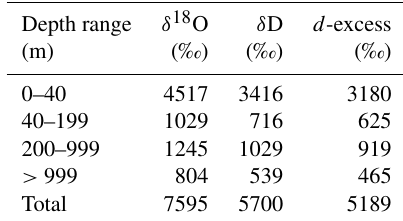
Table 3. Number of valid seawater isotopic data by depth range in Waterisotopes-CISE-LOCEAN (2021, version V2) (a total of 7595 valid data entries for δ 18 O out of 7703 data entries).